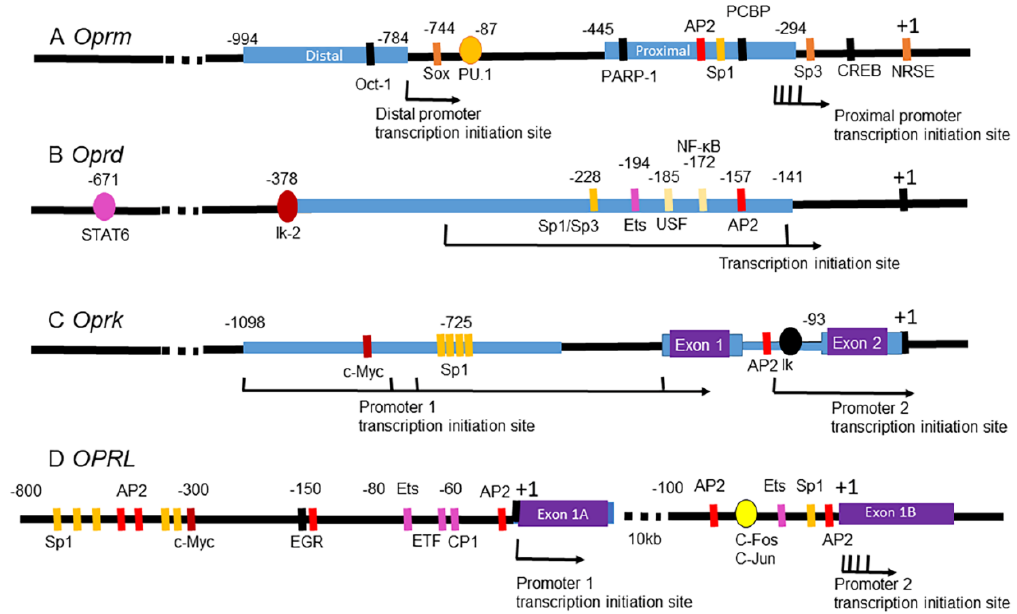
Figure 2. The regulatory DNA elements and corresponding TFs within the promoters of mouse Oprm ( A ), Oprd ( B ), Oprk ( C ), and human OPRL ( D ) genes. ( A – C ) Thick blue lines highlight validated promoters [6,154]. ( D ) Predicted regulatory elements and TF-binding sites at the human OPRL gene. Black arrows indicate reported transcription initiation sites from the promoters. ( A – D ) +1 shows the initiation codon of the open reading frame. Purple boxes are exons. Numbers above each map indicate the relative ends of validated promoter regions, regulatory sequences, or TF-binding sites, with respect to the +1 codon. Abbreviations: AP1, activator protein 1; AP2, activator protein 2; CREB, cyclic adenosine monophosphate (cAMP) response element binding protein; NF- κB, nuclear factor κB; Ets, E -twenty six; Ik, Ikaros; NRSE, neurorestrictive silencer element; Oct-1, octamer-1; PARP1, poly(ADP-ribose) polymerase 1; PCBP, poly C binding protein; PU.1, PU box binding; Sox, Sry-like high-mobility group box gene; Sp1, specificity protein 1; Sp3, specificity protein 3; STAT, signal transducers and activators of transcription; USF, upstream stimulatory factor; c-Myc, cellular Myelocytomatosis; EGR, early growth response protein; ETF, electron transfer flavoprotein; CP1, CCAAT transcription factor.